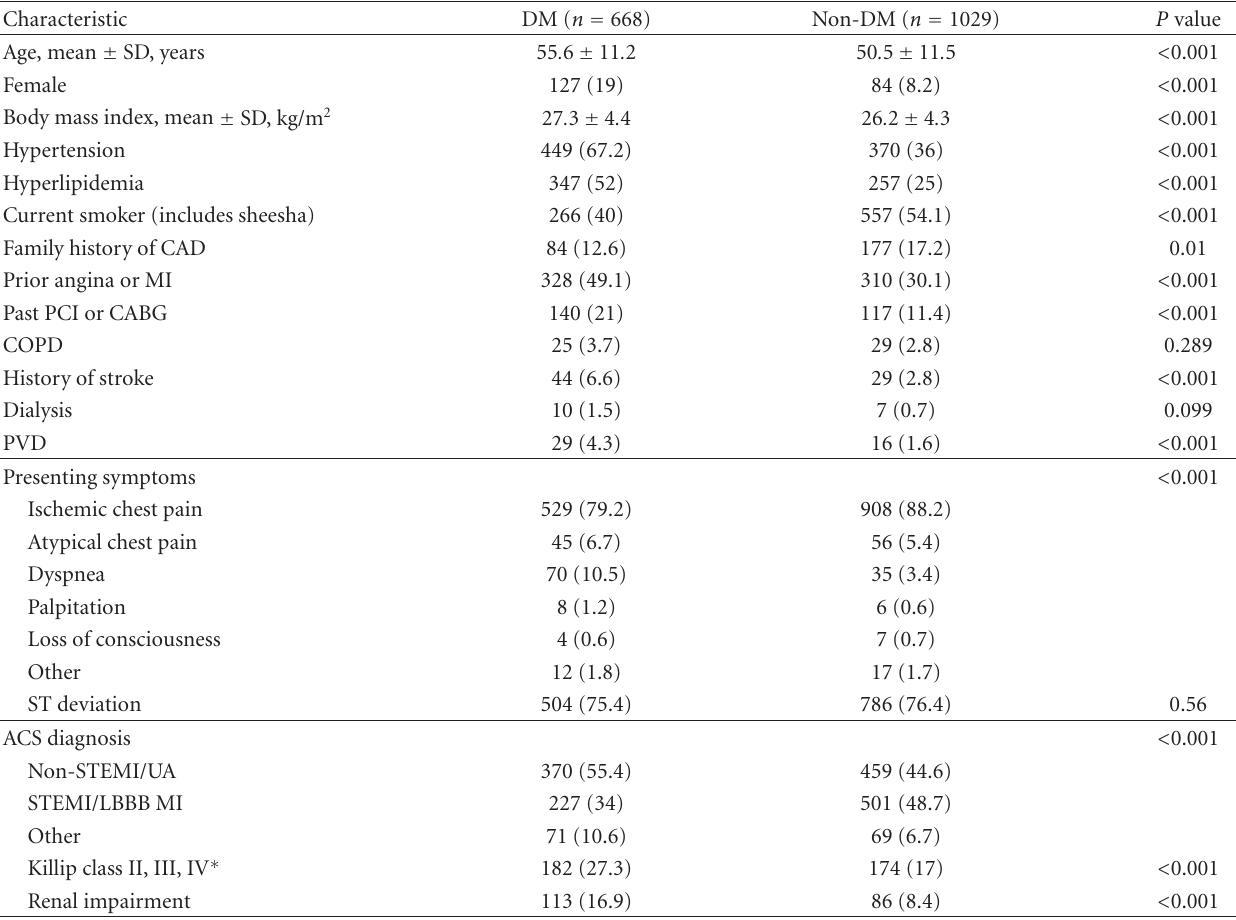
Table 1: Demographic and other baseline characteristics of the studied subjects ( n =